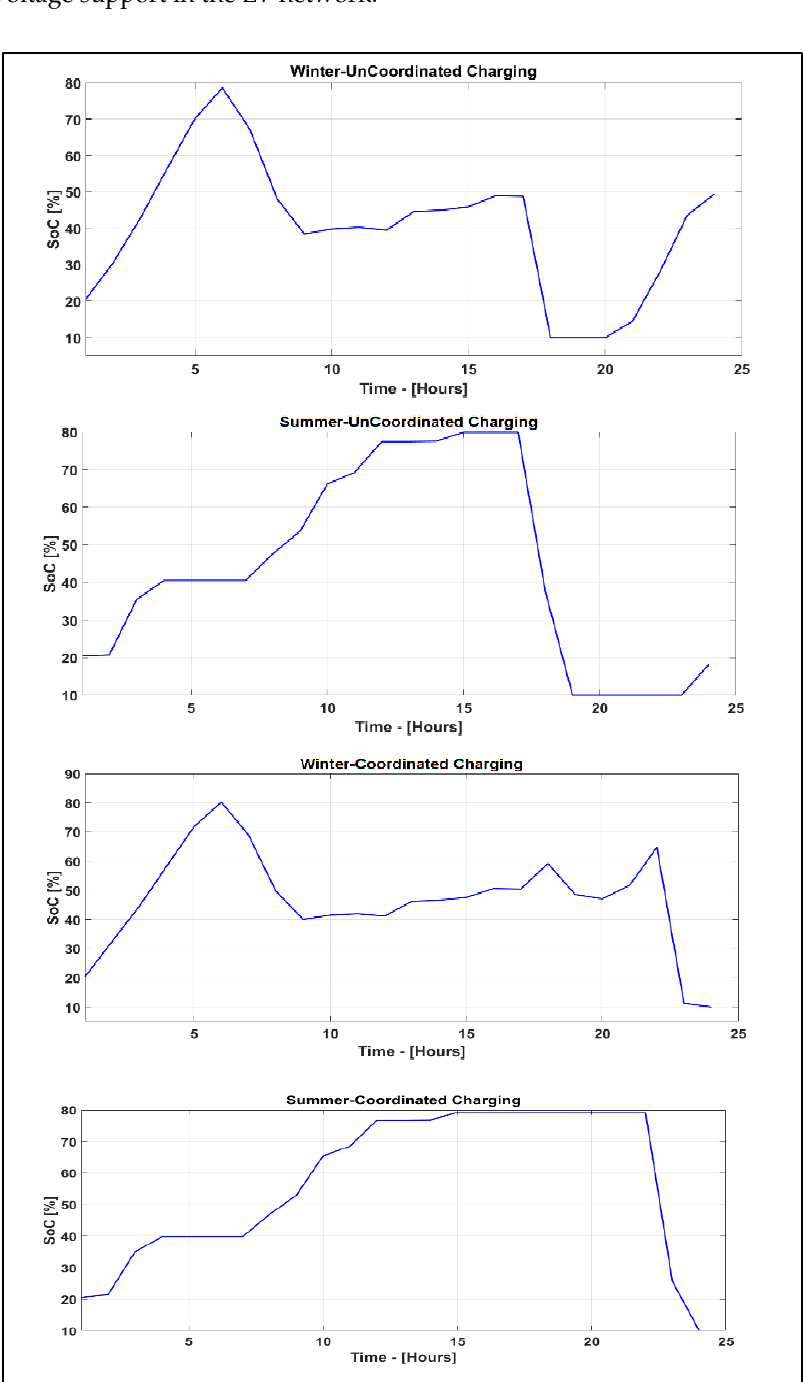
Figure 11. BESS state of charge (SoC) under multiple simulated scenarios.